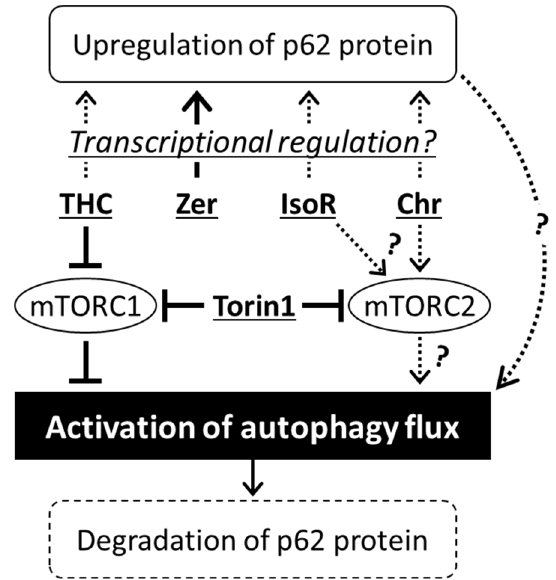
Figure 7. Possible molecular mechanisms underlying autophagy activation by phytochemicals. THC, 2,2 ′ ,4 ′ -trihydroxychalcone; Zer, zerumbone; IsoR, isorhamnetin; Chr, chrysoeriol.